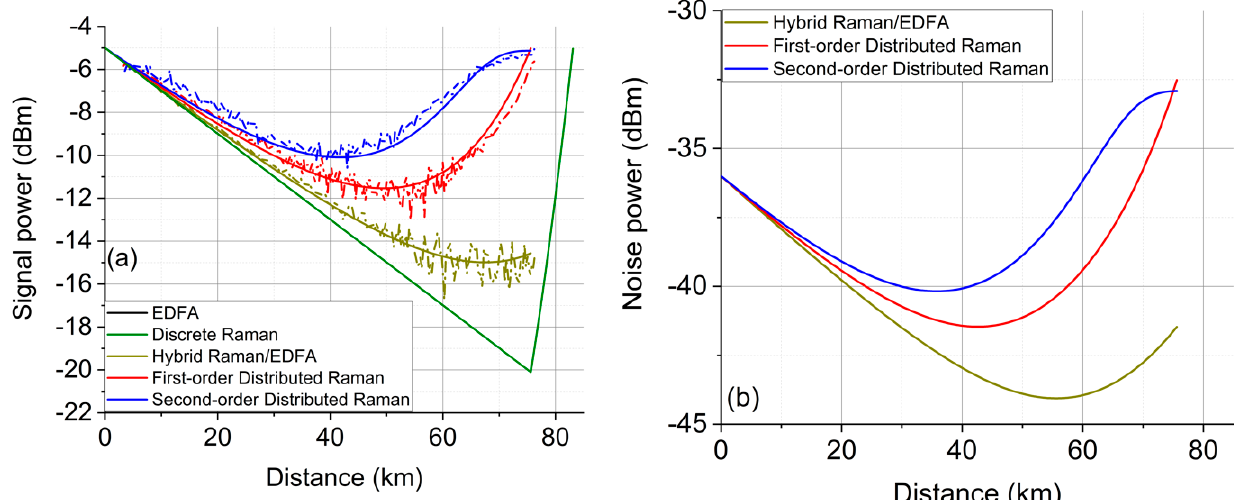
Figure 2. ( a ) Experimentally measured (dotted line) and simulated (solid line) signal power profiles along the fibre with five different amplification schemes; ( b ) Simulated noise power profiles along the fibre.